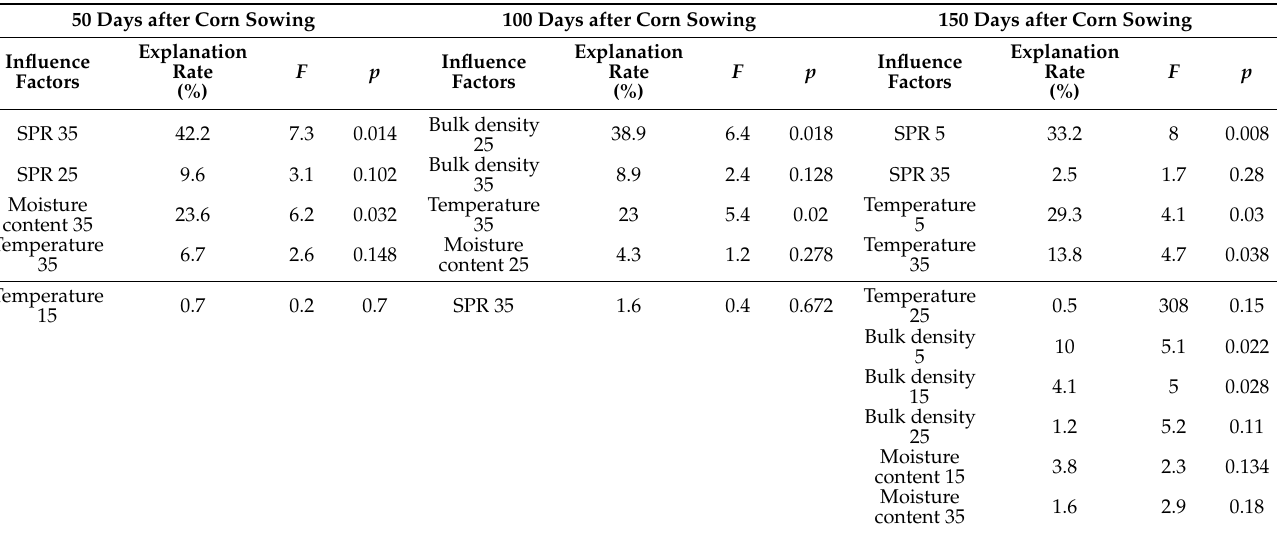
Table 5. Explanatory degree and significance test of impact